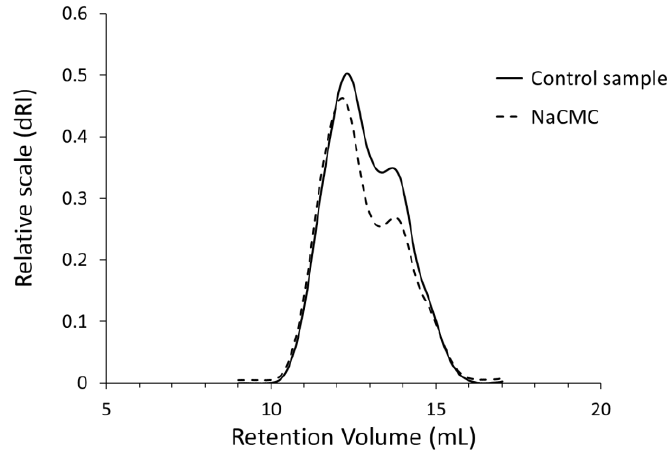
Figure 2. Size exclusion chromatography (SEC) curves of native NaCMC (-------) and NaCMC recovered after being left in contact with 13.5 eq. of benzylamine, for 4 h at 140 °C ( ).